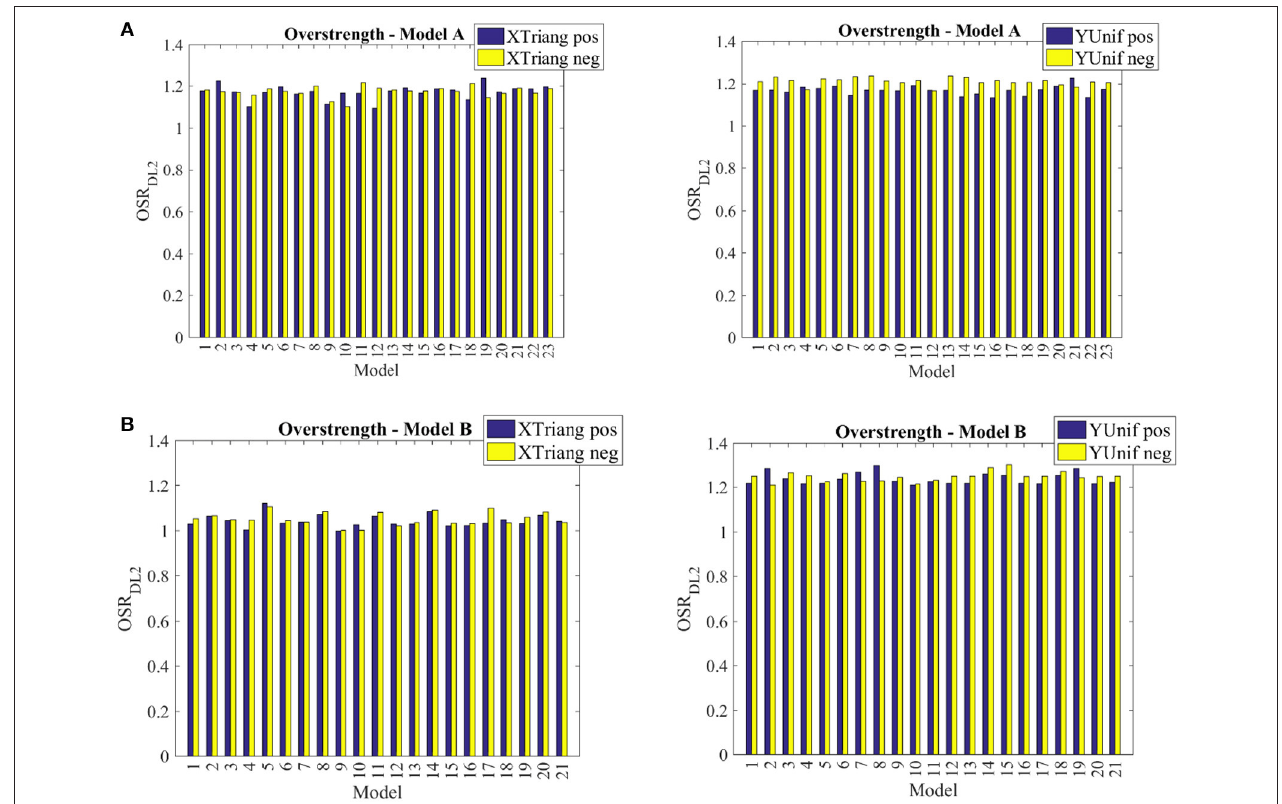
FIGURE 14 | Overstrenght for X and Y direction for Model A (A) and Model B (B) adopting